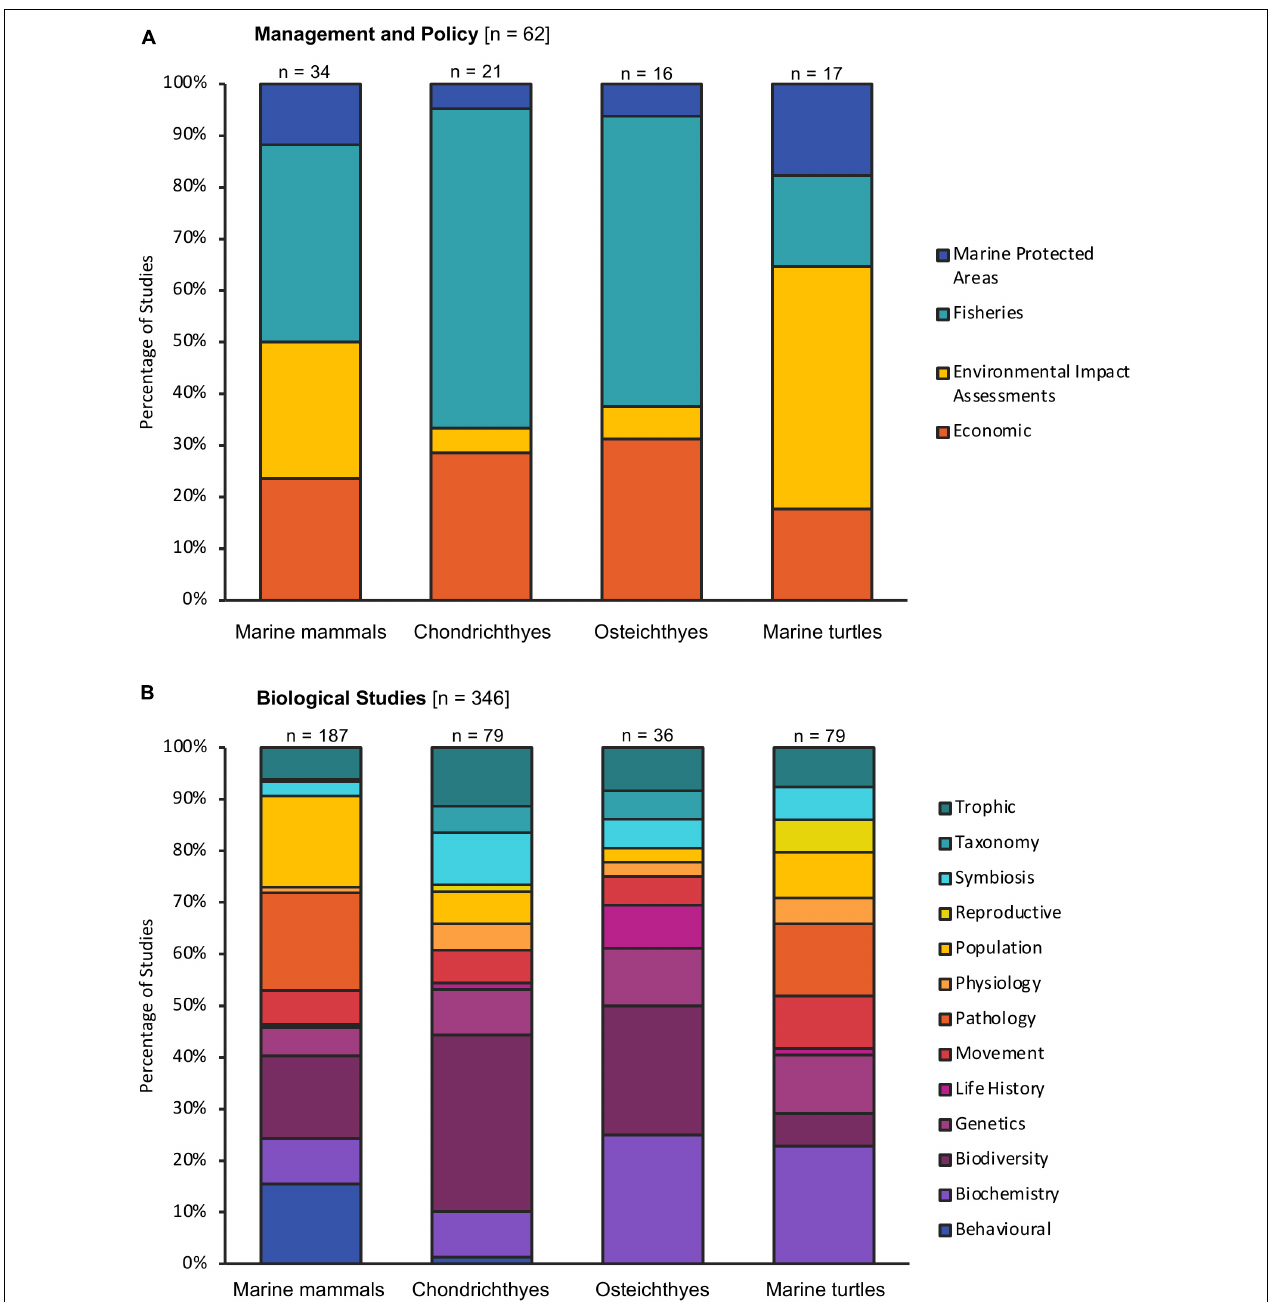
FIGURE 4 | Trends of sub-disciplines among reviewed papers corresponding to: (A) management and policy and (B) biological